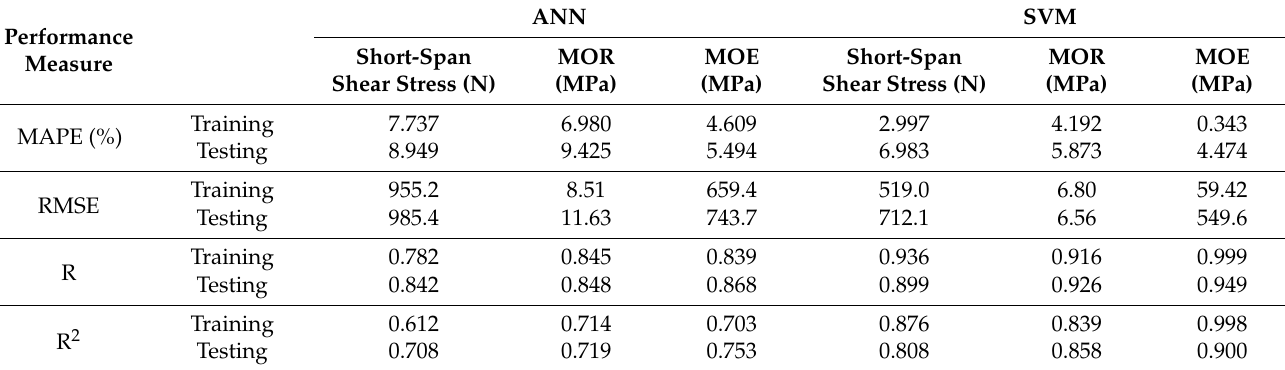
Table 2. Performance measure used for predicting the short-span shear stress, MOR and MOE by ANN and SVM.